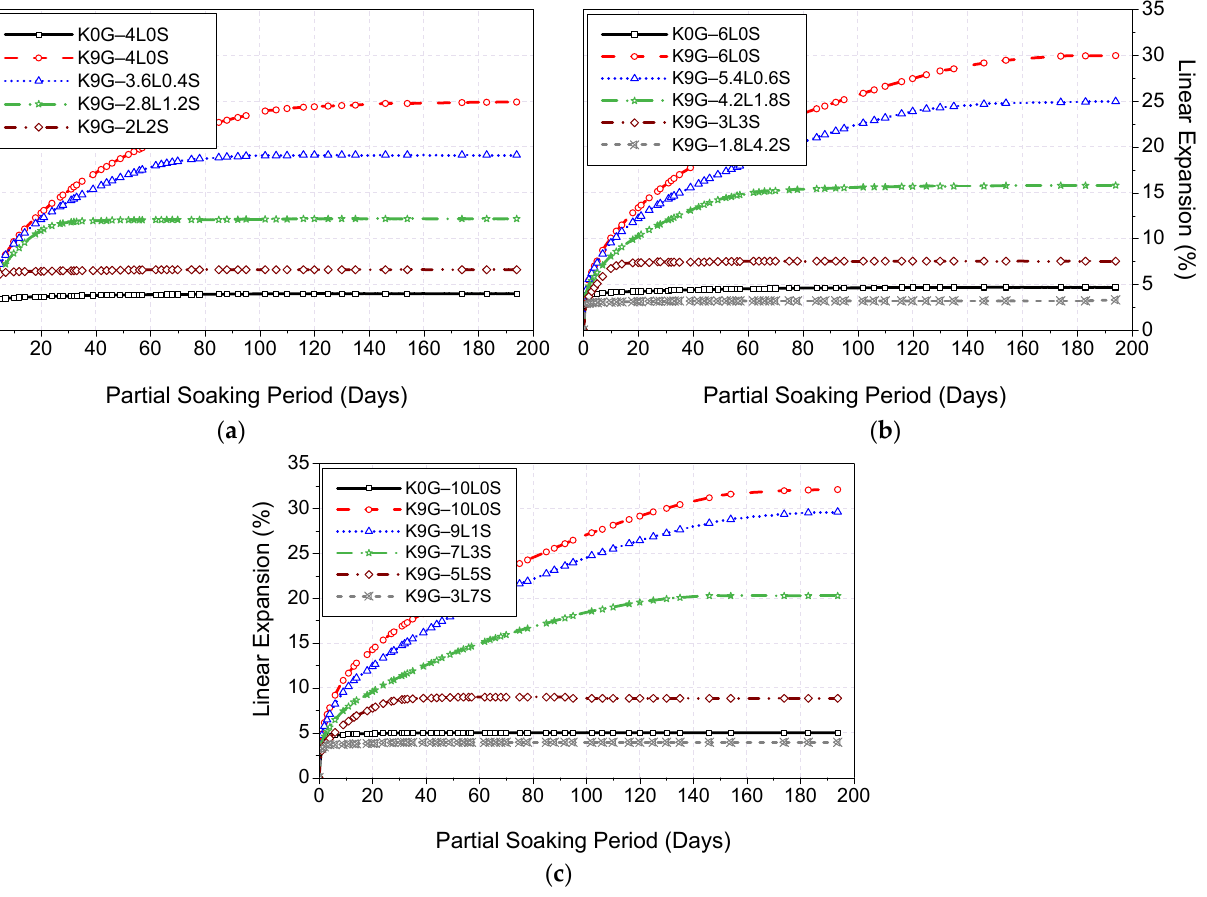
Figure 6. Typical 200-day expansion trends of kaolinite specimens dosed with 0 and 9% of gypsum and stabilised with various binary blends of lime and silica fume at binder dosages of ( a ) 4, ( b ) 6, and ( c ) 10 wt%.